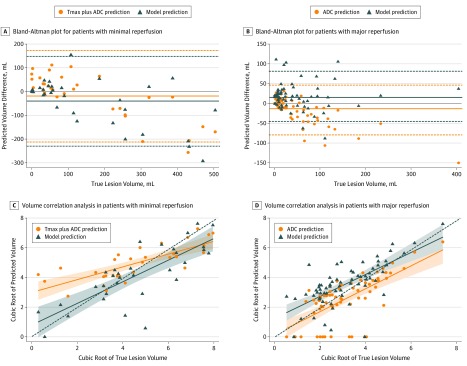
Bland-Altman Plots and Volume Correlation Analyses From the Deep Learning Model and Thresholding Methods in Patients With Minimal and Major ReperfusionA and B, The solid lines represent mean and the dotted lines marking the shaded areas represent upper and lower limit of agreement. C and D, Because the data are not normally distributed in the volume correlation analysis, the cubic root of the volume is plotted for clarity. In part D, apparent diffusion coefficient (ADC) thresholding erroneously predicted a zero lesion size more commonly than the deep learning model (13 vs 2 patients, respectively). Solid lines indicate fitted linear regression line; dashed lines, reference lines when the correlation coefficient equals 1; and shaded area, 95% CI of fitted linear regression from the SE of the prediction.